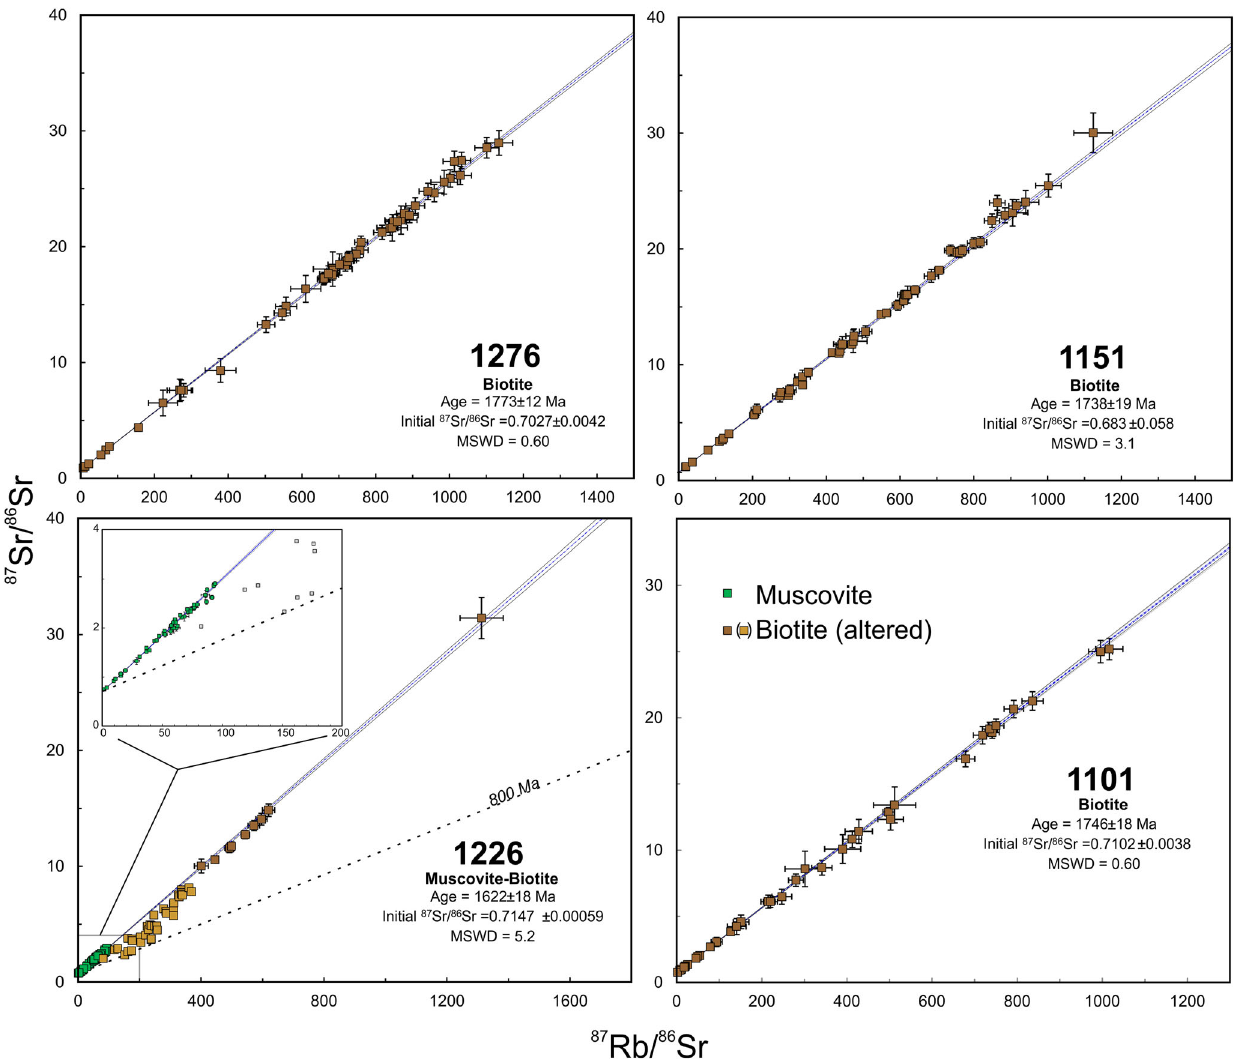
Fig. 3 Rb – Sr isochron diagrams. Rb – Sr biotite (muscovite) isochron diagrams for mylonites, Akia Terrane, Greenland. Each panel contains the isotopic results from one sample as indicated by the sample number in the lower right of each plot. Error bars are shown at the two- σ level. Uncertainties around the regressions are at the 95% con fi dence